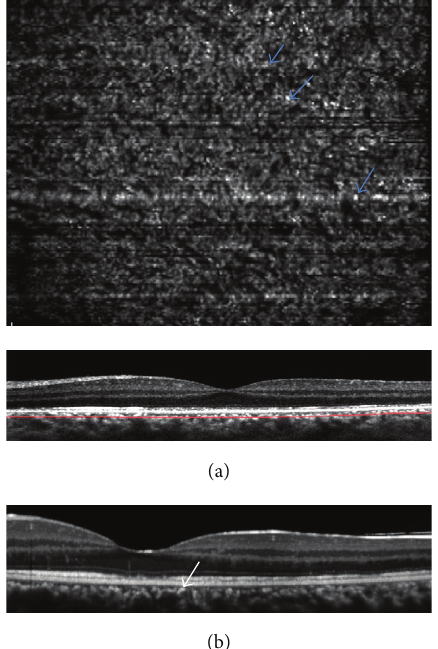
Figure 5: (a) “En-face” EDI SD-OCT at the level of the choriocapillaris with hyperreflective points (blue arrows) that matched (b) the hyperreflective points observed on B-scan in the choriocapillaris (white arrow).